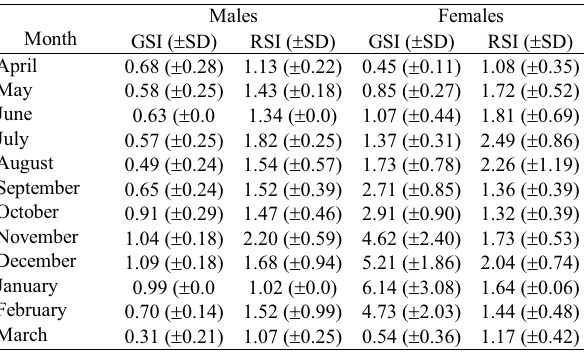
Table 1. Monthly mean values of GSI (± SD) and RSI (± SD)for males and females of A. anisitsi collected from April 2001 to March 2002 in the arroio do Salso, Rosário do Sul, RS, Brazil. GSI = Gonadosomatic Index; RSI = Stomach Repletion Index; SD = Standard